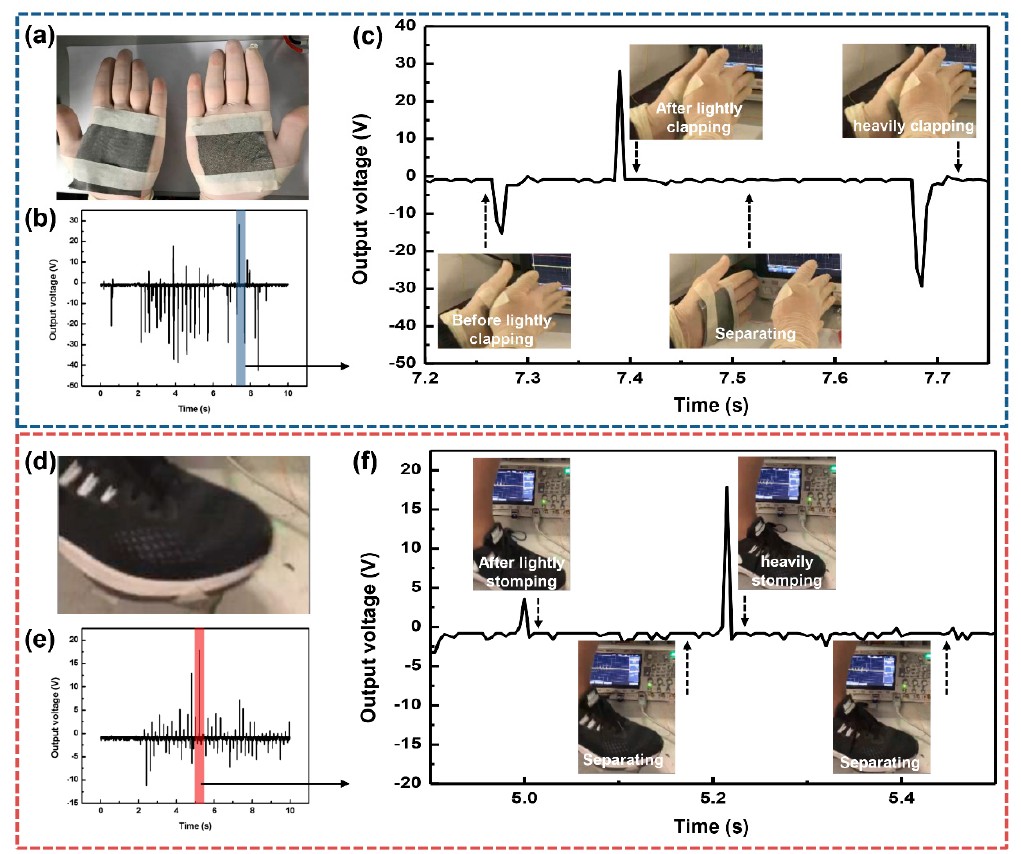
Figure 9. Illustration of the P3000-T-TENG harvesting energy from human motion. ( a ) Photograph of rectangle-shaped P3000-PACF composite film and ACF electrode taped to two palms, respectively. ( b ) Practically measured voltage in response to clapping palms under different force and frequency. ( c ) The corresponding status of clapping palms. ( d ) Photograph of P3000-PACF composite film and ACF taped to a shoe and floor, respectively. ( e , f ) Practically measured voltage in response to stomping and the corresponding status of a foot under repeated stomping. Note: the areas of P3000-PACF composite film and ACF are both 50 × 60 mm 2 .